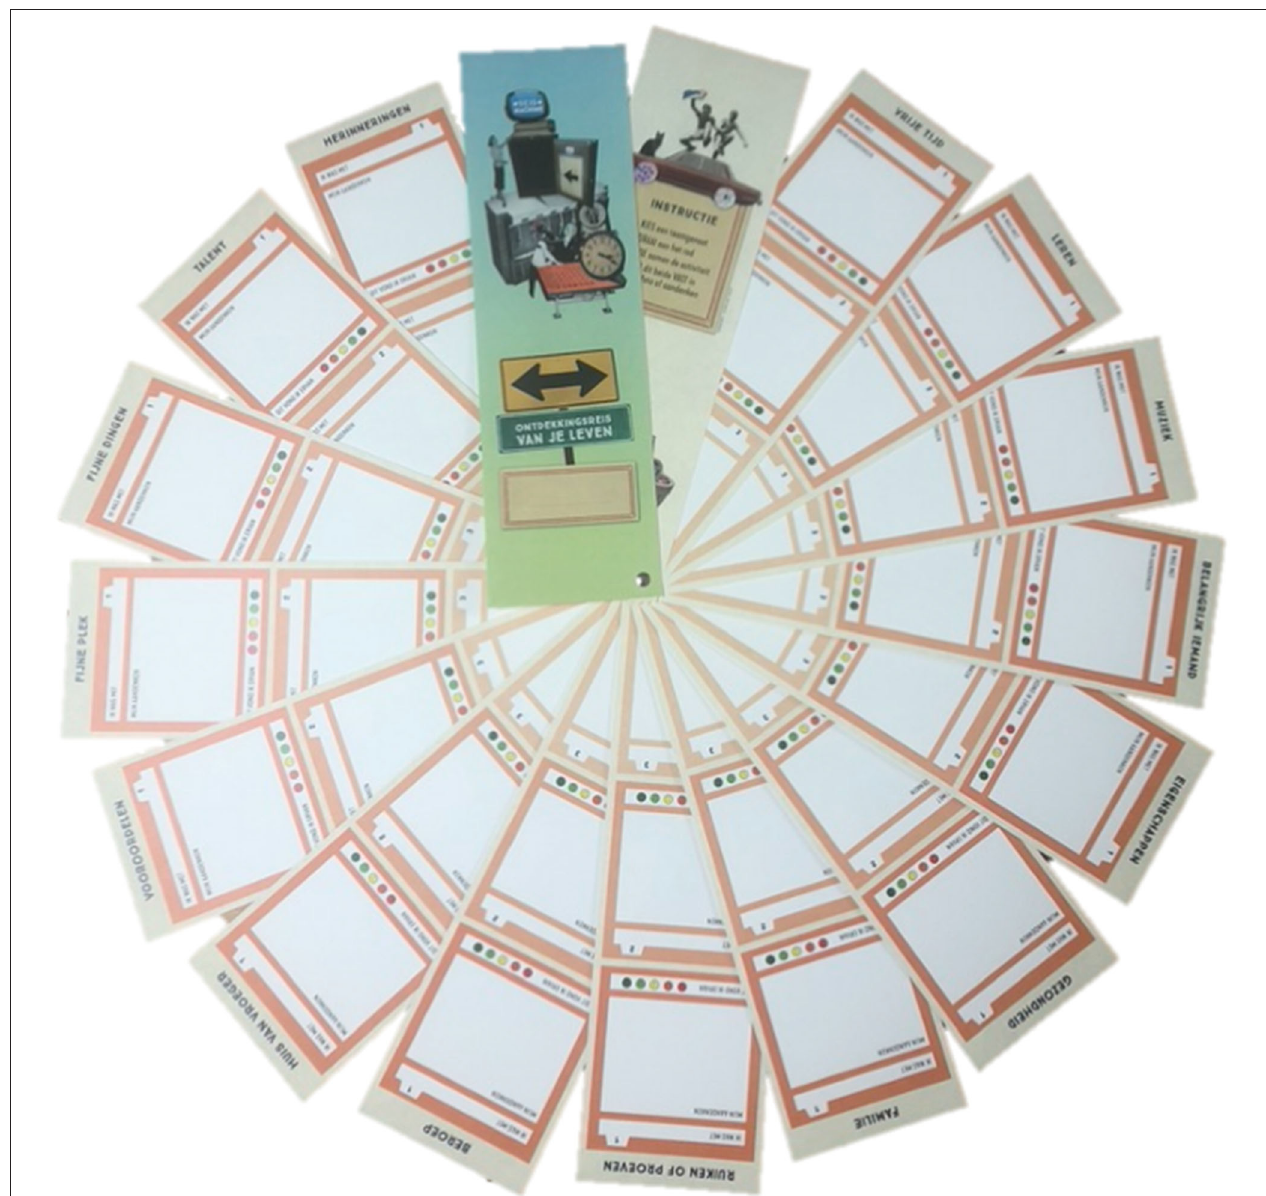
FIGURE 4 | Hand fan